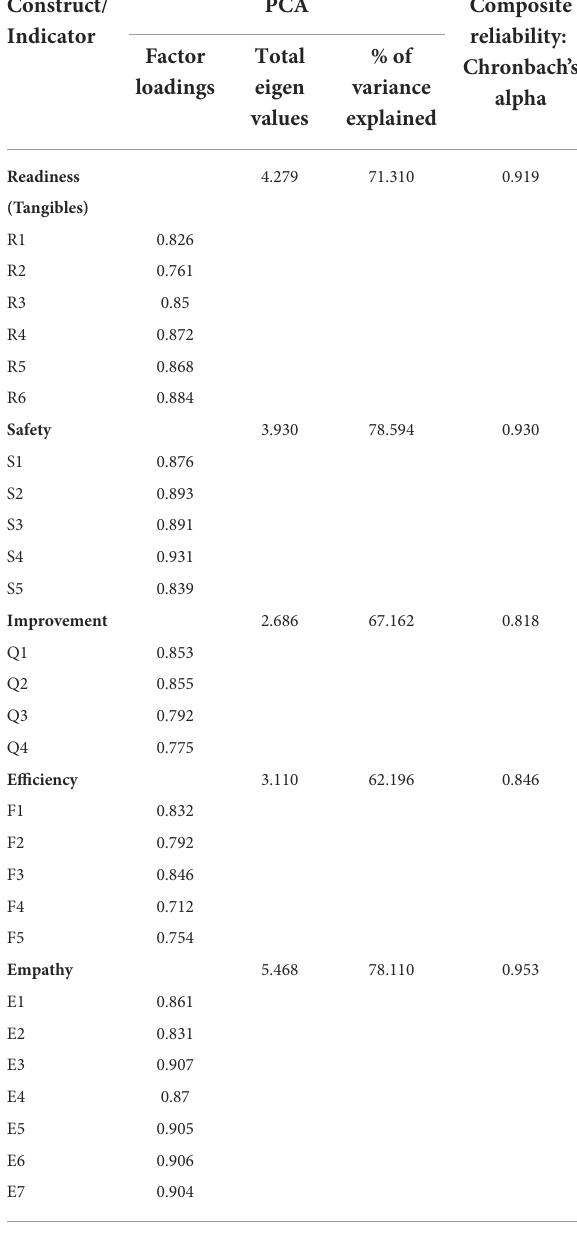
TABLE 3 Factor loadings and composite reliability of